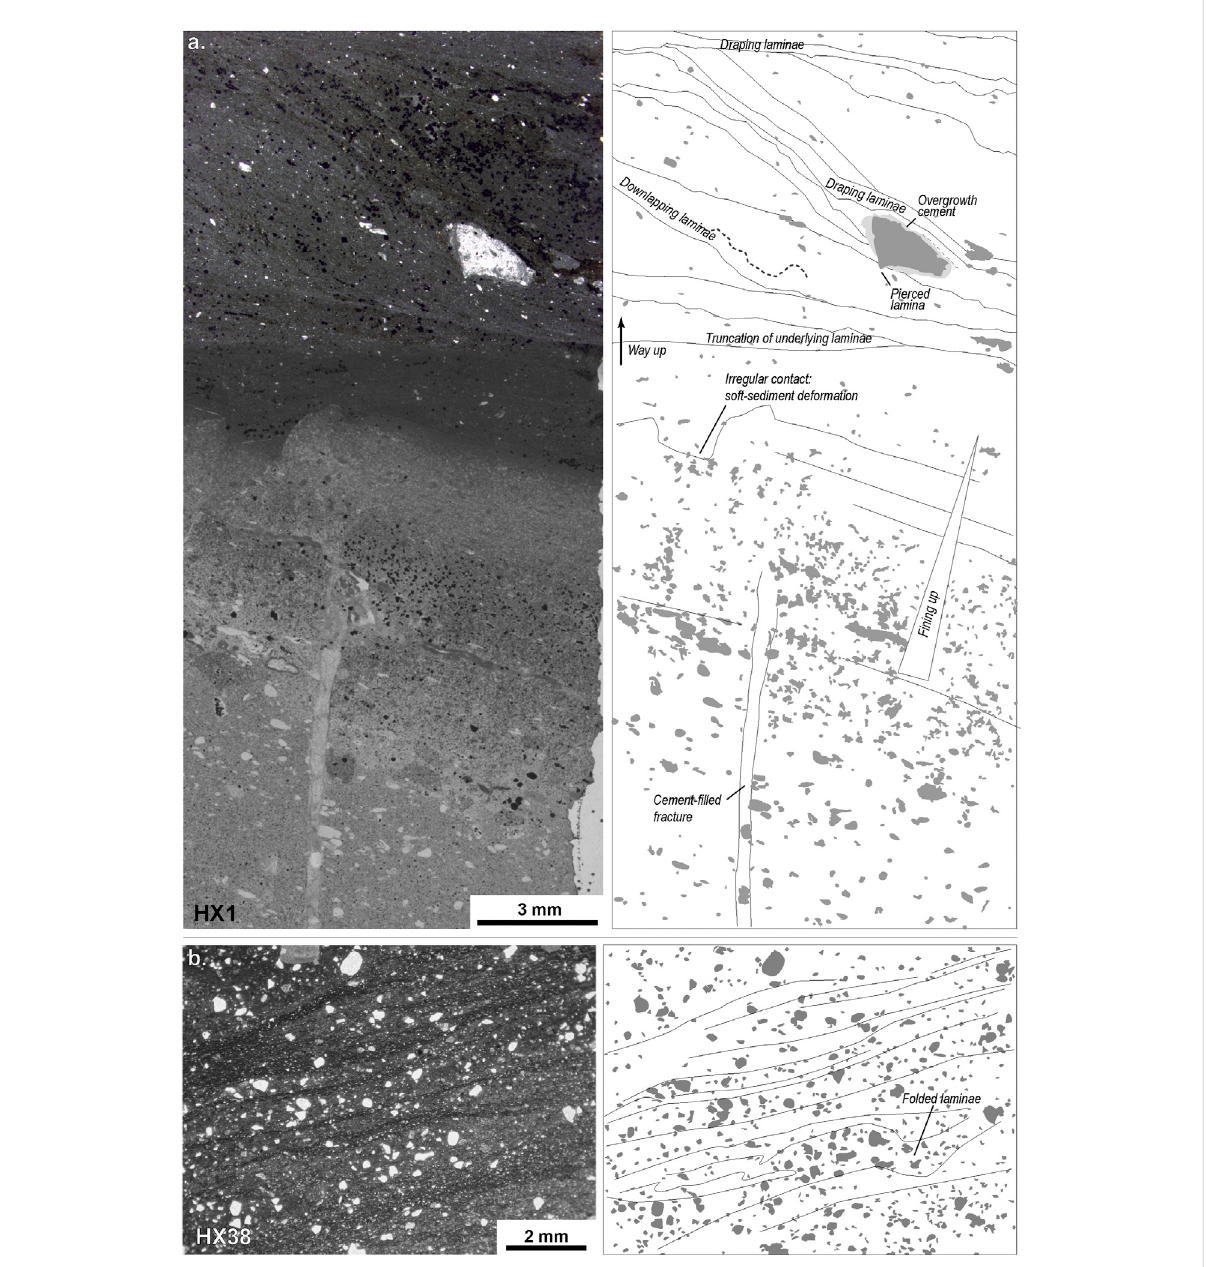
FIGURE 8 Thin section analysis/micromorphological interpretation of two intervals in the HEX 5 core (see Figure 3 for stratigraphic position of samples). (A) Contact between the basal (Rooinekke) ironstone and diamictite of the Makganyene above. Note presence of small lonestone that pierces underlying laminations. (B) Pervasively strati fi ed deposits with evidence for small-scale